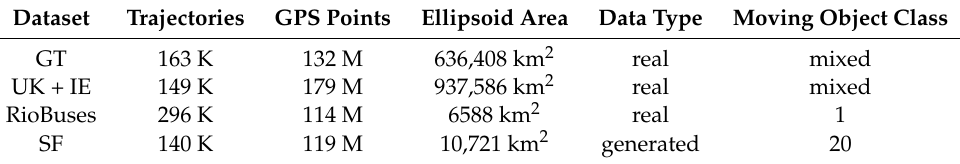
Table 1. Moving object trajectory datasets used in training and